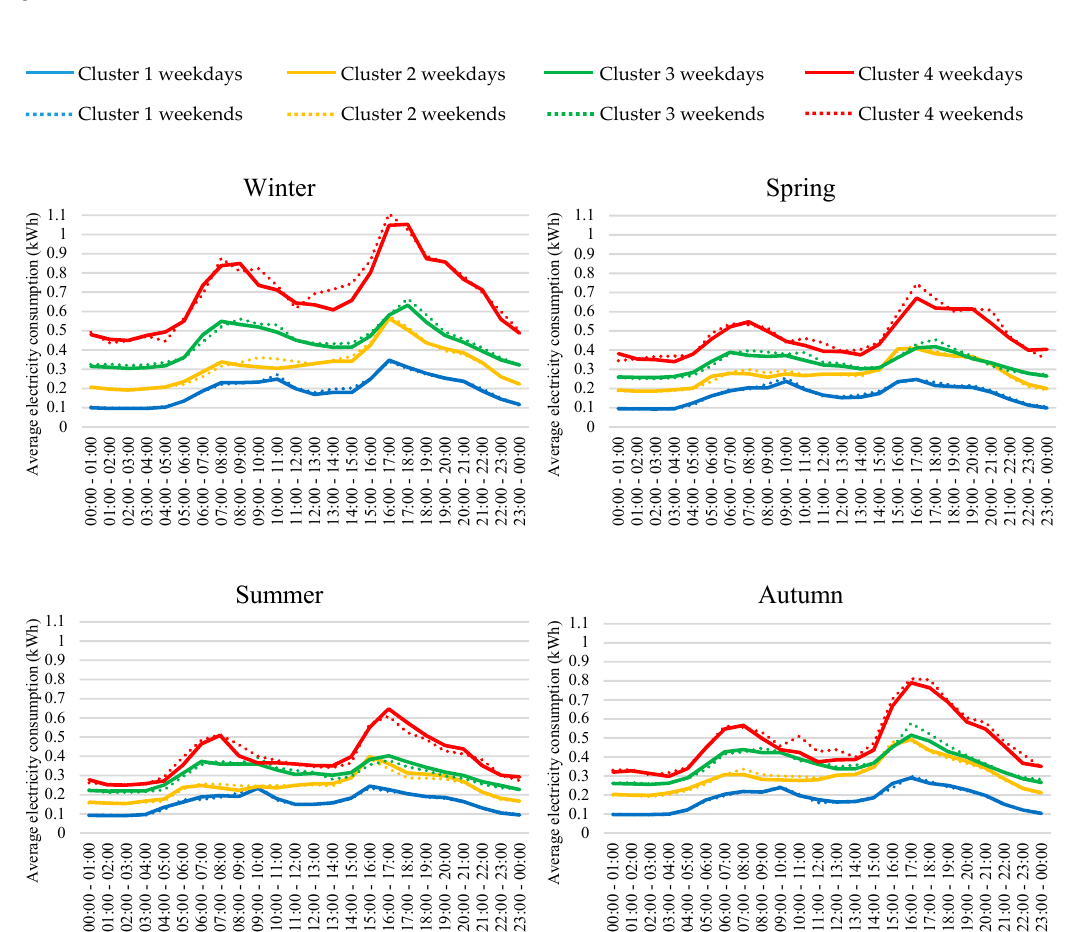
Figure 3. Seasonal average electricity consumption (kWh) by the hours of the weekdays and weekends